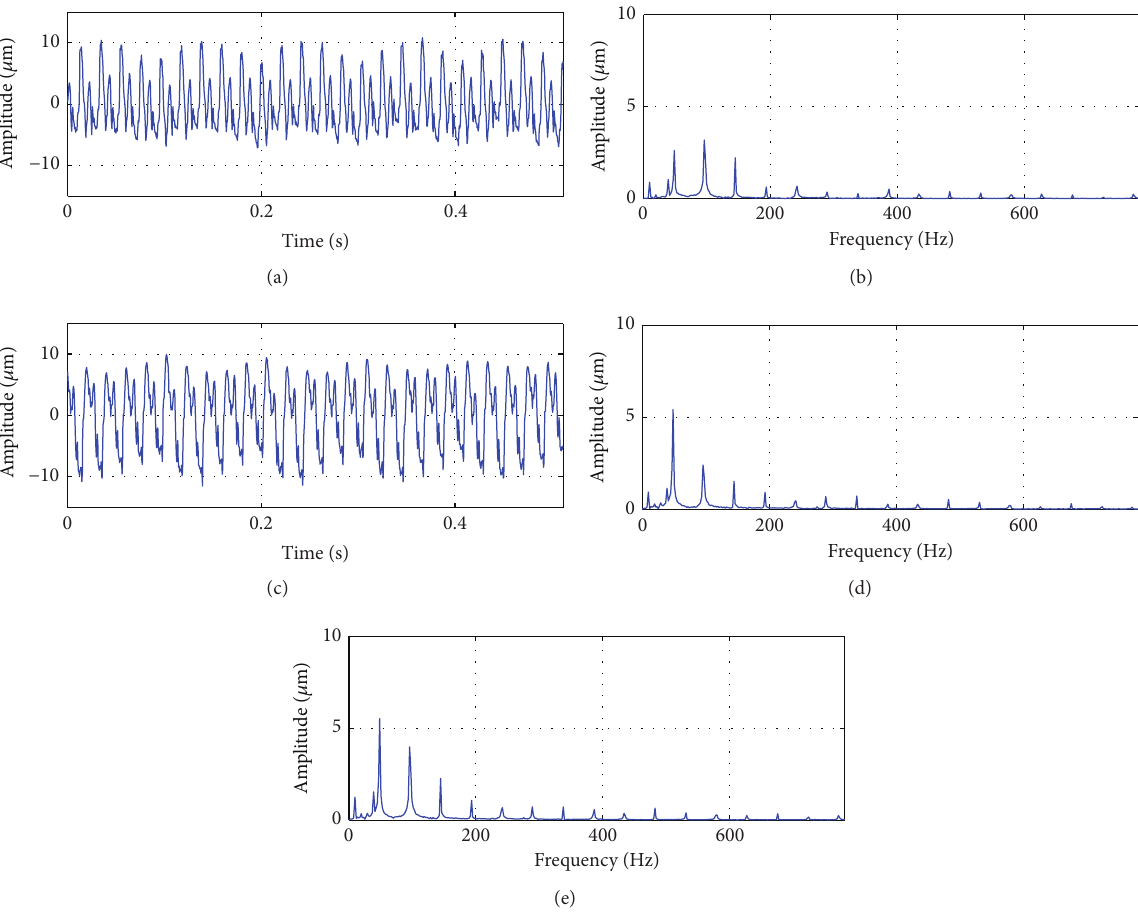
Figure 9: (a) Vibration wave of 𝑥 -direction; (b) spectrum of 𝑥 -direction; (c) vibration wave of 𝑦 -direction; (d) spectrum of 𝑦 -direction; (e) full-vector spectrum.